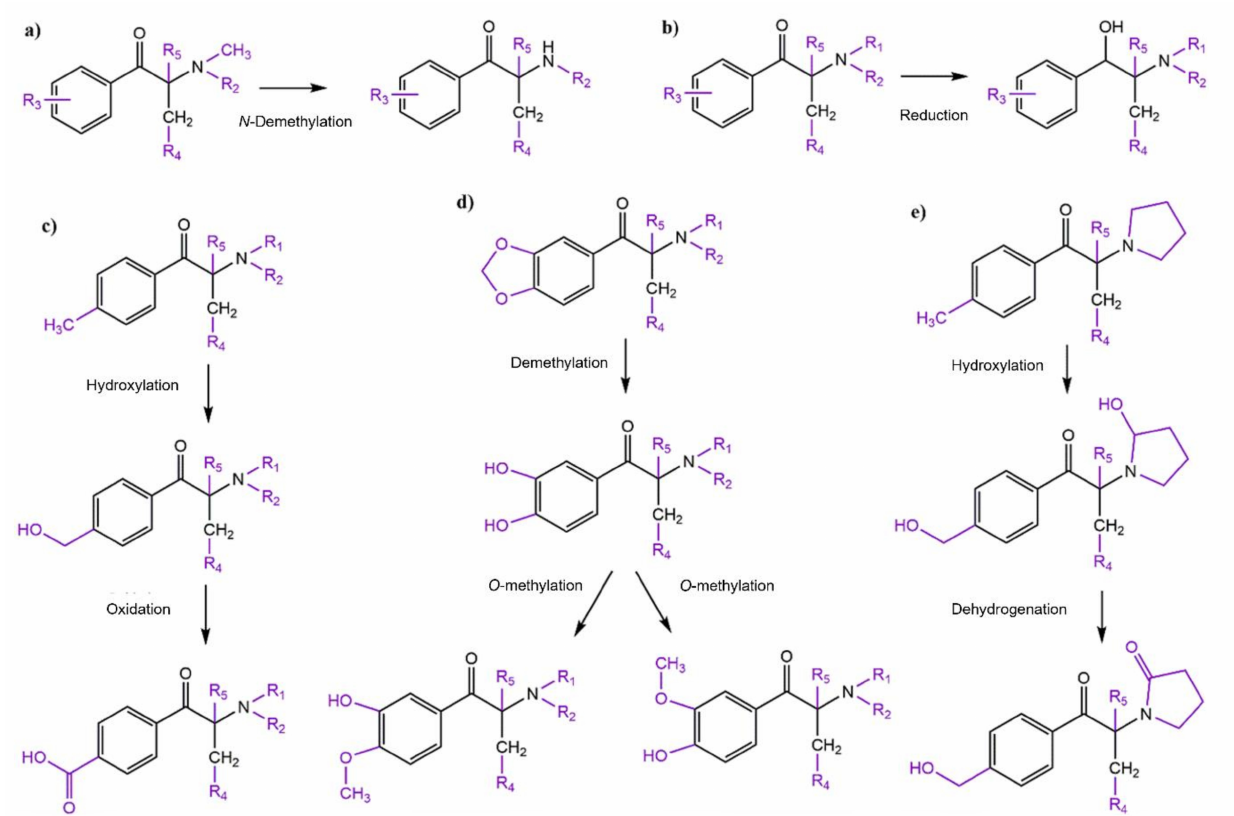
Figure 10. General metabolic pathways of synthetic cathinones: ( a ) main metabolic pathways of N -alkylated cathinones; ( b ) reduction of the β -keto moiety to an alcohol; ( c ) hydroxylation and further oxidation of the methyl substituent of the aromatic ring to a carboxylic acid; ( d ) metabolism of the 3,4-methylenedioxy ring; ( e ) metabolism of the pyrrolidinyl ring to a